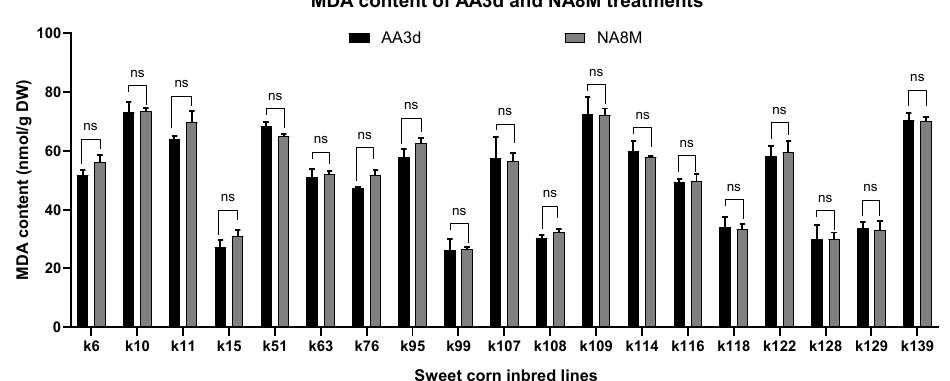
Figure 4. Comparative analysis of MDA content between AA3d and NA8M seeds in 19 sweet corn lines. ‘ns’ corresponds to p > 0.05.